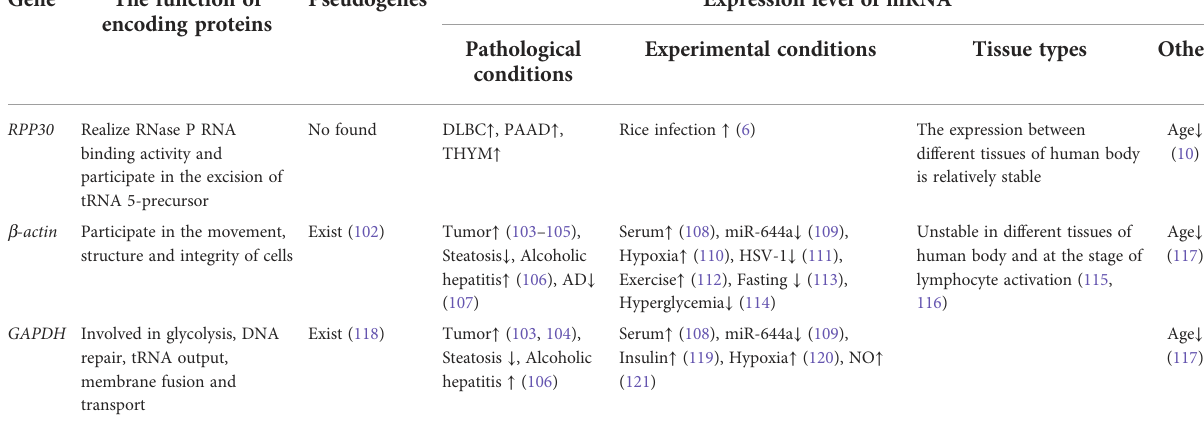
TABLE 3 Comparing RPP30 with other internal